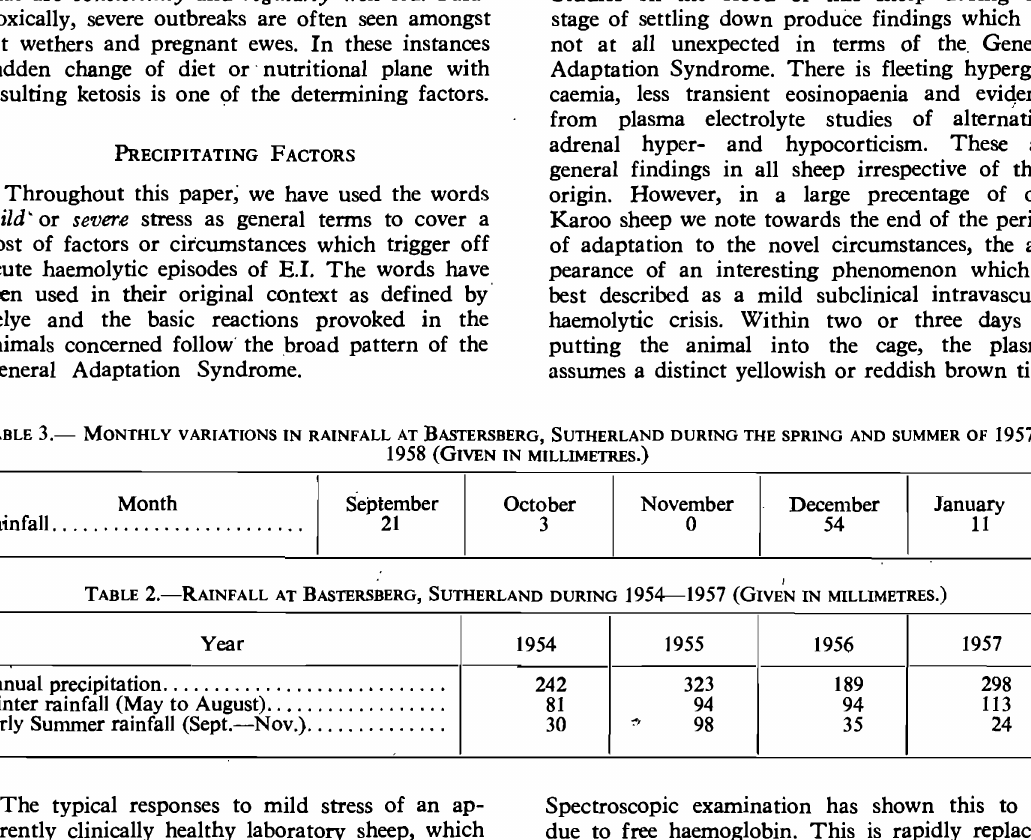
TABLE 2.-RAINFALL AT BASTERSBERG, SUTHERLAND DURING 1954-1957 (GIv~N IN MILLIMETRES.)